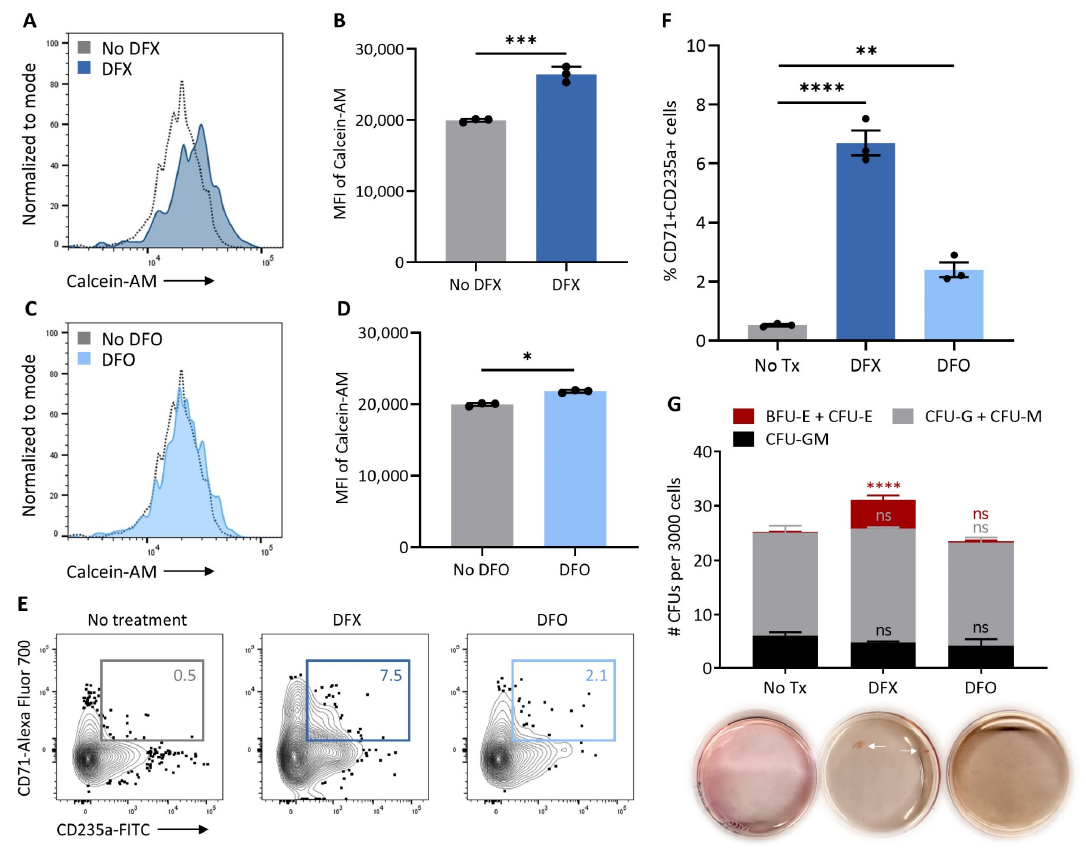
Figure 4. Intracellular iron restriction improves erythropoiesis in DBA iPSCs. ( A – D ) Quantification of intracellular iron chelating properties of DFX and DFO in erythroid cells differentiated from isogenic iPSCs. Representative flow cytometry histograms of intracellular calcein-AM fluorescence ( A , C ) and summary of the mean fluorescence intensity of calcein-AM ( B , D ) in isogenic iPSC-derived erythroid cells loaded with calcein-AM and then treated or not with DFX ( A , B ) or DFO ( C , D ). Peak height of each histogram was normalized to mode. ( E ) Representative flow cytometry contour plots depicting percentages of late-stage CD45- erythroblasts co-expressing CD71 and CD235a at culture day 21 of DBA iPSC differentiation in in the absence of an iron chelator (no treatment) or in the presence of deferasirox (DFX) or deferoxamine (DFO). ( F ) Percentages of CD71 + CD235a+ late-stage CD45 − erythroblasts at culture day 19 or 21 of DBA iPSC differentiation in the absence of an iron chelator (No Tx, no treatment) or in the presence of DFX or DFO ( n = 3). ( G ) Number of CFUs per 3000 hematopoietic cells harvested at day 19 or 21 of DBA iPSC differentiation in the absence of an iron chelator (No Tx) or in the presence of DFX or DFO ( n = 4). Insets at the bottom are representative CFU plates; white arrows point to erythroid colonies. In panels B, D, F and G, data are presented as mean ± SEM. In panel G, statistical analysis is presented for each colony type relative to the “No Tx” group. Unpaired t -test, * p ≤ 0.05, ** p ≤ 0.01, *** p ≤ 0.001, **** p ≤ 0.0001, ns: not